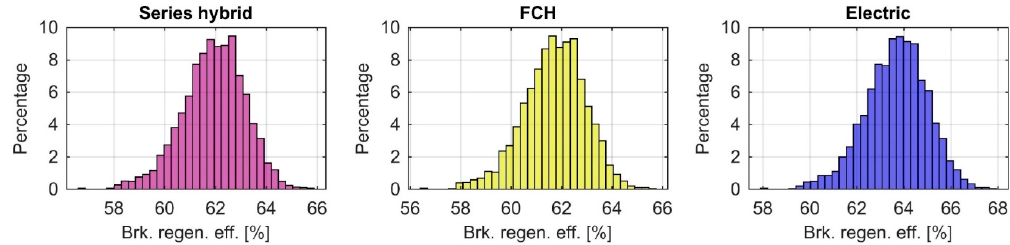
Figure 13. Regenerative braking efficiency histograms. Table 9. Regenerative braking efficiency statistics.